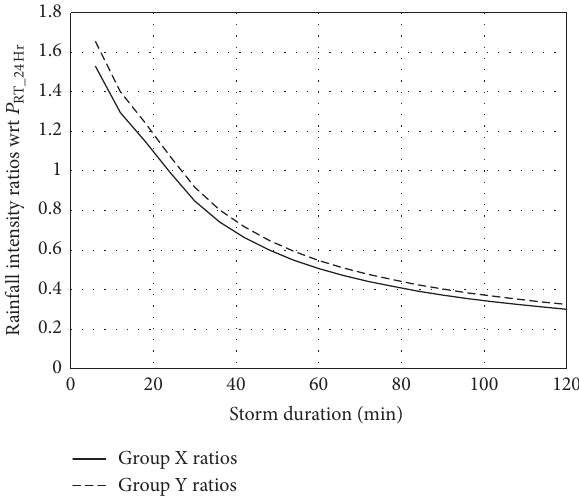
Figure 4: Intensity ratio curve for groups X and